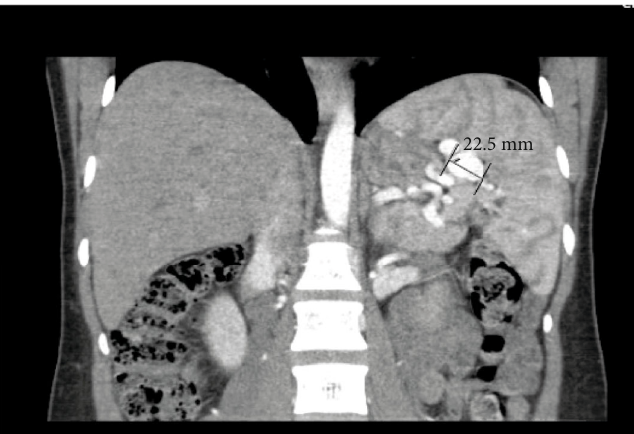
Figure 1: CT abdomen with contrast showing the splenic artery aneurysm (reproduced from Meghan et al. [9], [under the Creative Commons Attribution License/public